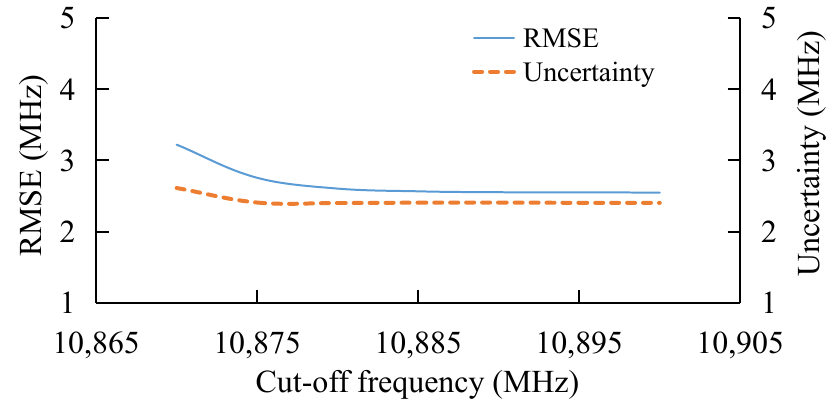
Figure 4. BFS extraction under different cut-off frequency.